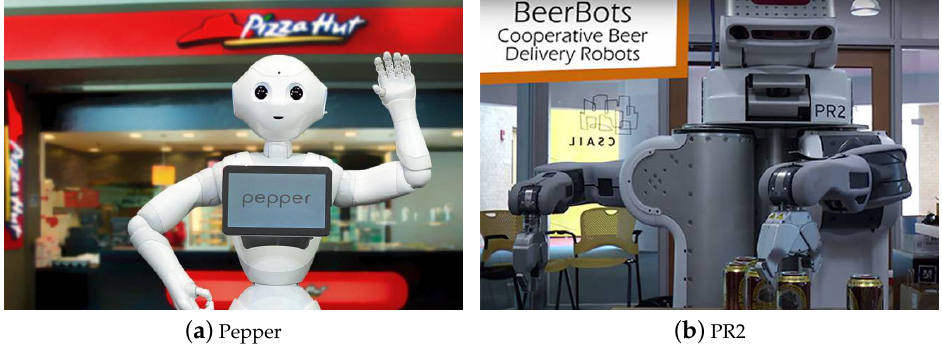
Figure 7. Two different examples of waiter robots. ( a ) Pepper. The social humanoid robot from SoftBank Robotics. ( b ) PR2. The robotic research platform by Willow